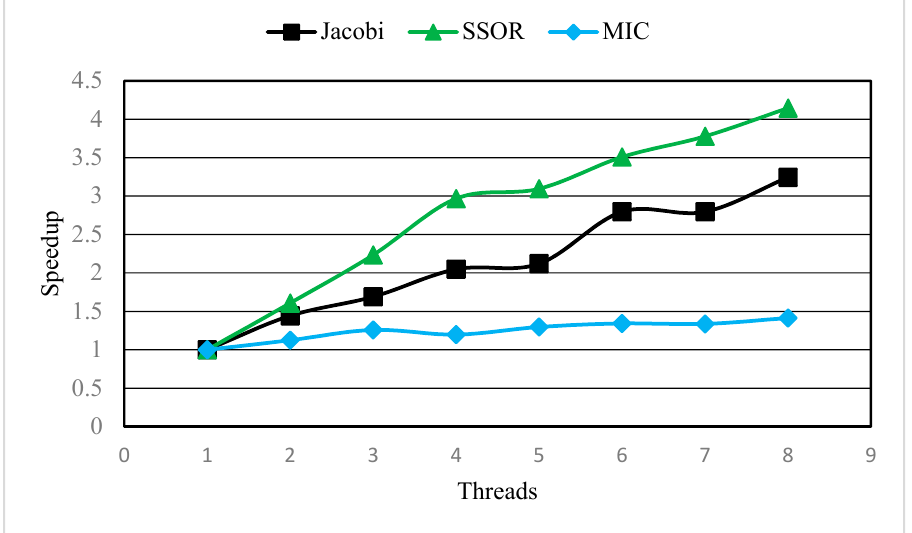
Figure 6. The dependence of speedup on the number of threads for different preconditioning options.